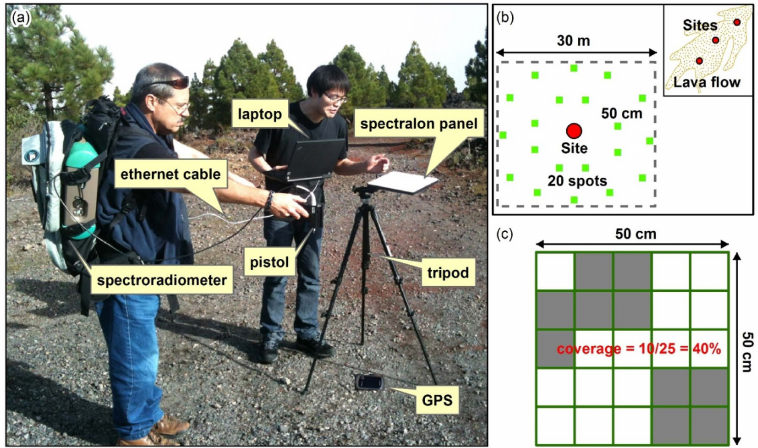
Figure 2. Illustration of the field measurement strategy: ( a ) spectral measurement using an ASD field spectroradiometer, an IBM laptop, a spectralon panel fixed on a tripod and a handheld GPS placed on the ground; ( b ) distribution of spots (green squares) around the center of the site on the lava flow surface; ( c ) quantifying the surface oxidation and lichen coverage with the plastic net method. This example shows that the surface of the spot scanned by the spectroradiometer pistol is 40% covered by